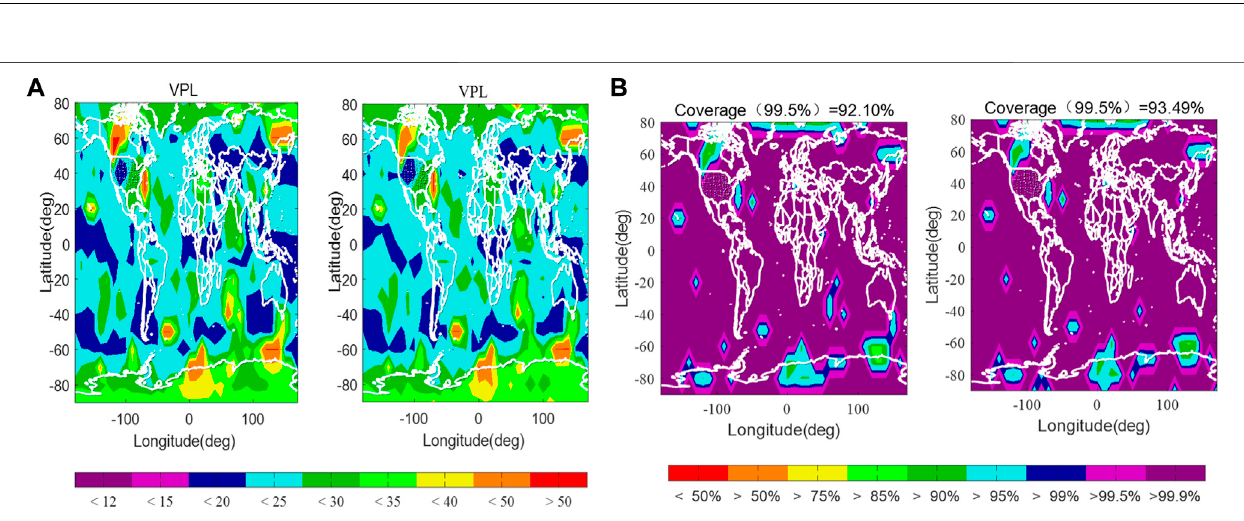
FIGURE 2 | Global VPL and ARAIM global availability under the second set of parameters (A) Global VPL corresponding to the two allocation methods under the second set of parameters. (B) Global availability of ARAIM corresponding to the two allocation methods under the second set of parameters.